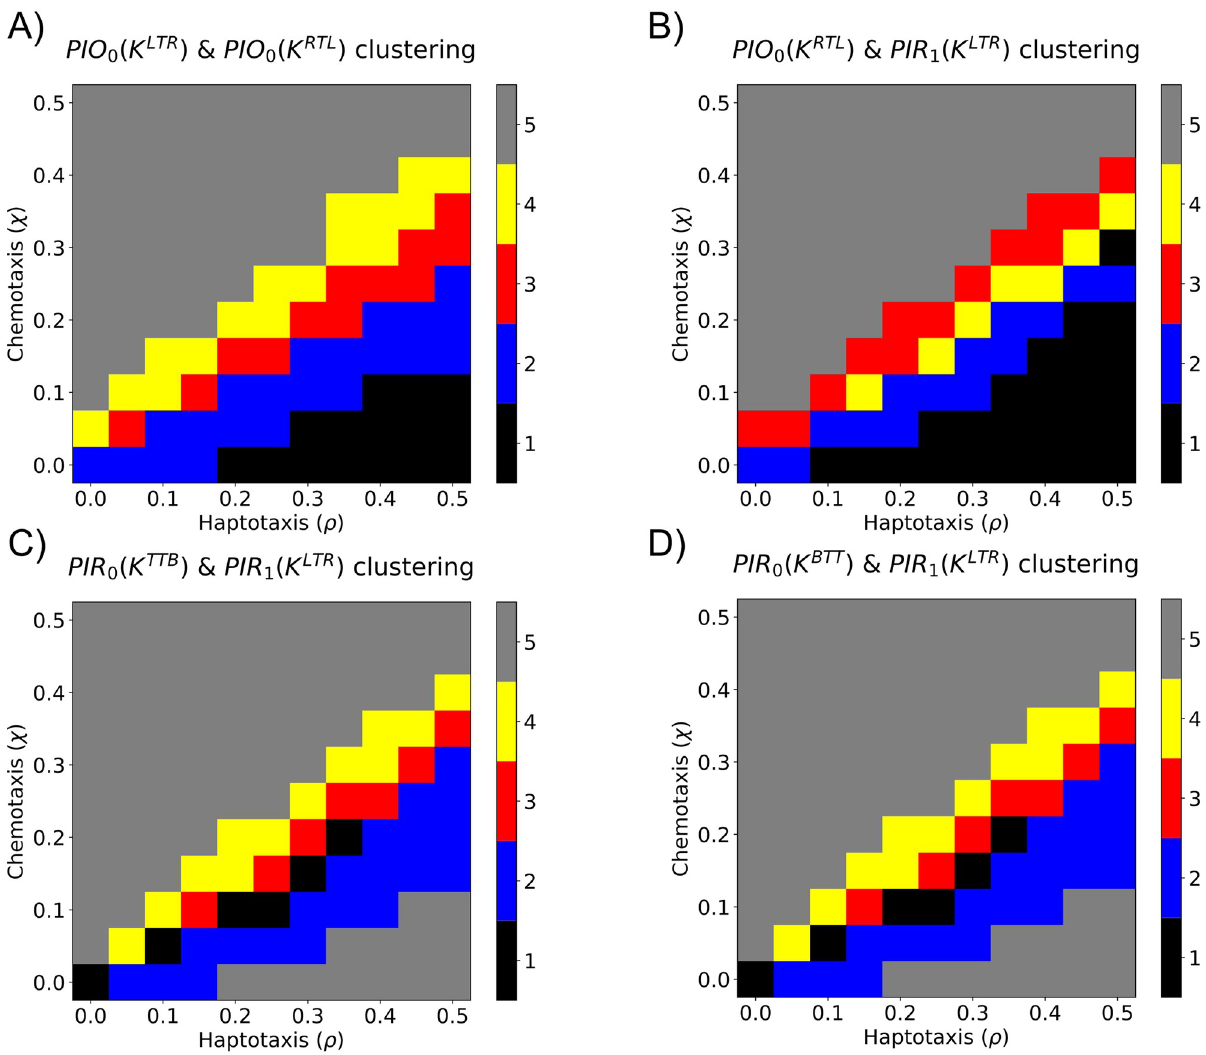
Fig 13. Partitioning ( ρ , χ ) parameter space into distinct regions using sweeping plane double descriptor vectors. We applied k -means clustering, with k = 5, to sweeping plane double descriptor vectors. The resulting partitions are presented for the four descriptor vectors that have the highest OOS accuracy: A) PIO 0 ( K LTR ) & PIO 0 ( K RTL ), B) PIO 0 ( K RTL ) & PIR 1 ( K LTR ), C) PIO 0 ( K TTB ) & PIR 1 ( K LTR ), and D) PIO 0 ( K BTT ) & PIR 1 ( K LTR ). The five clusters are ordered according to the mean χ value within the cluster.